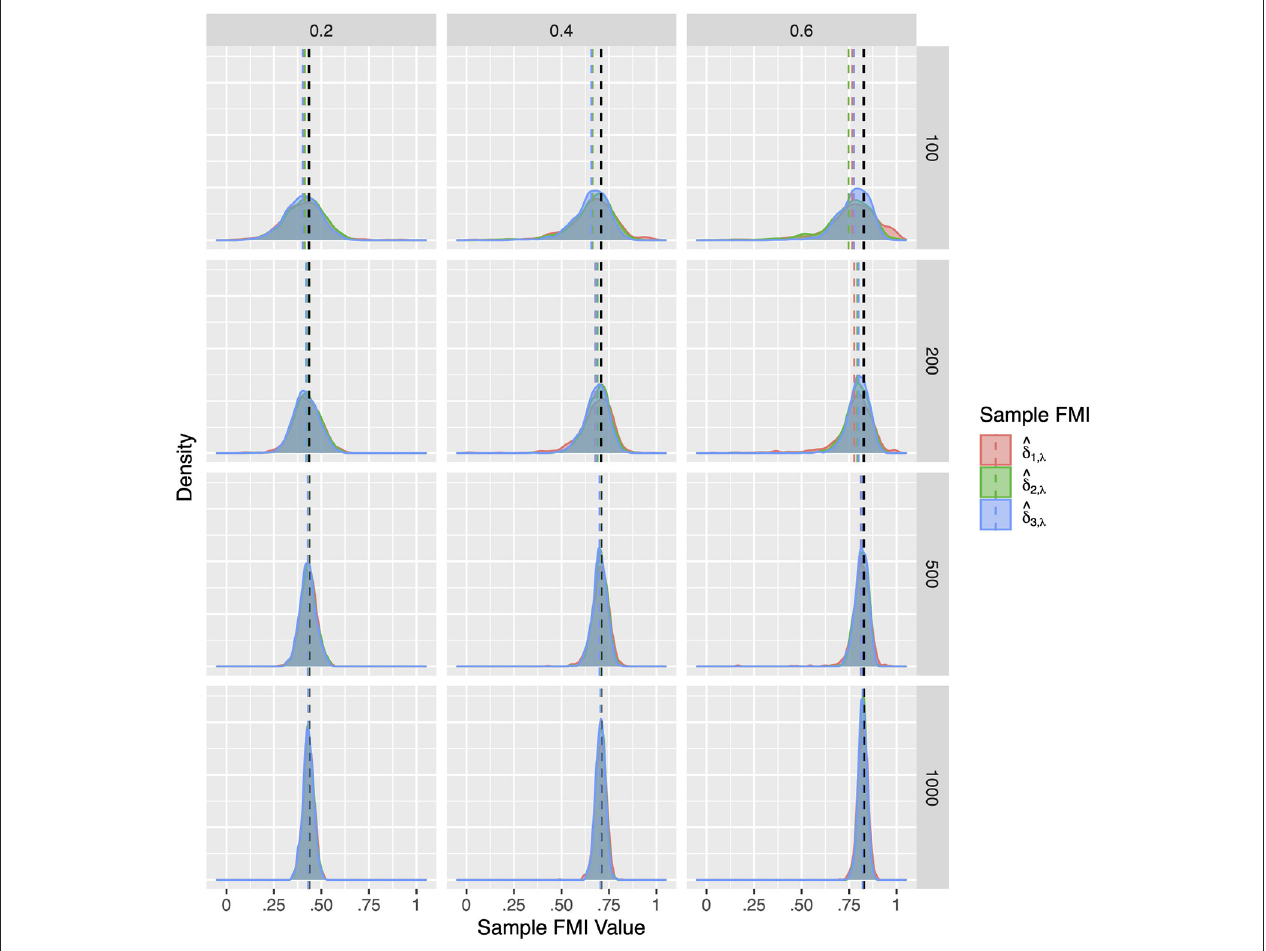
FIGURE 9 | The sampling distribution of FMI for factor loadings in nonlinear MAR. The panel rows correspond to sample sizes of N panel columns correspond to per variable missing rates of 20, 40, and 60%, or overall population missing rates of 10, 20, and 30%. The population FMI value in each panel is given as a vertical black dotted